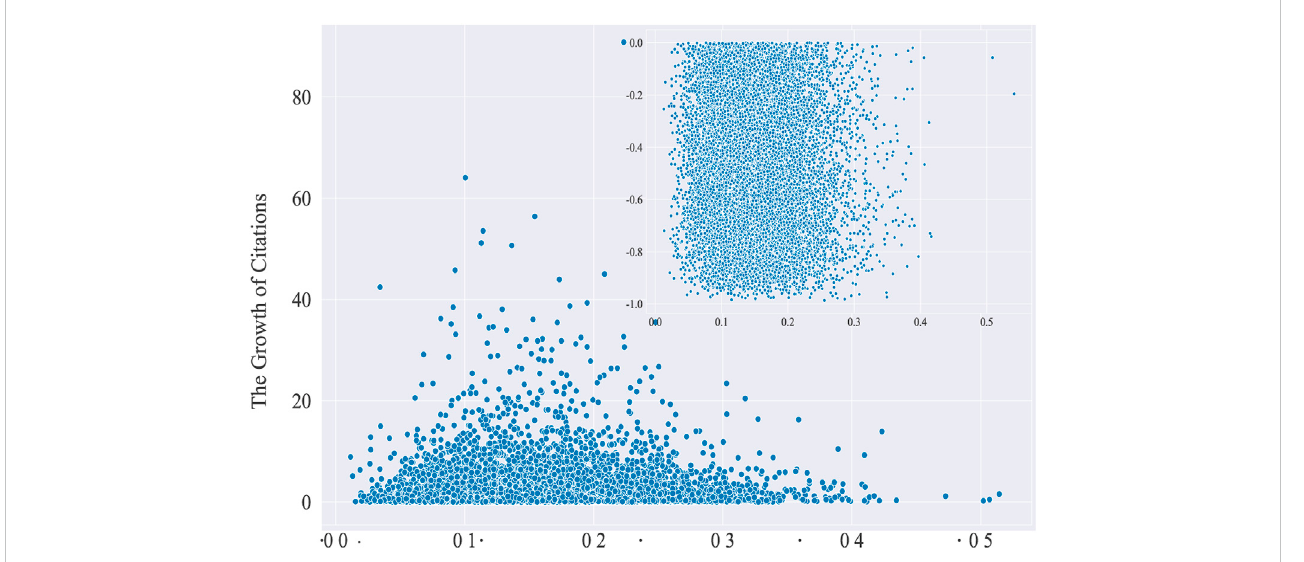
FIGURE 7 The distributionof citations ’ growth for theinterdisciplinary scientists. The blue dot is G c for each scientist. The insert picture shows thenegative growth for citations.